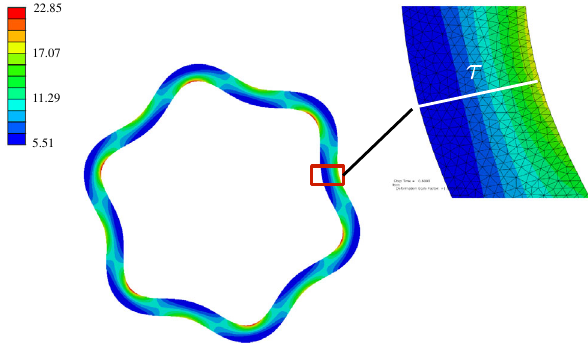
FIG. 6. Detail of normal thickness ( τ ) measurement. Color represents the von Mises